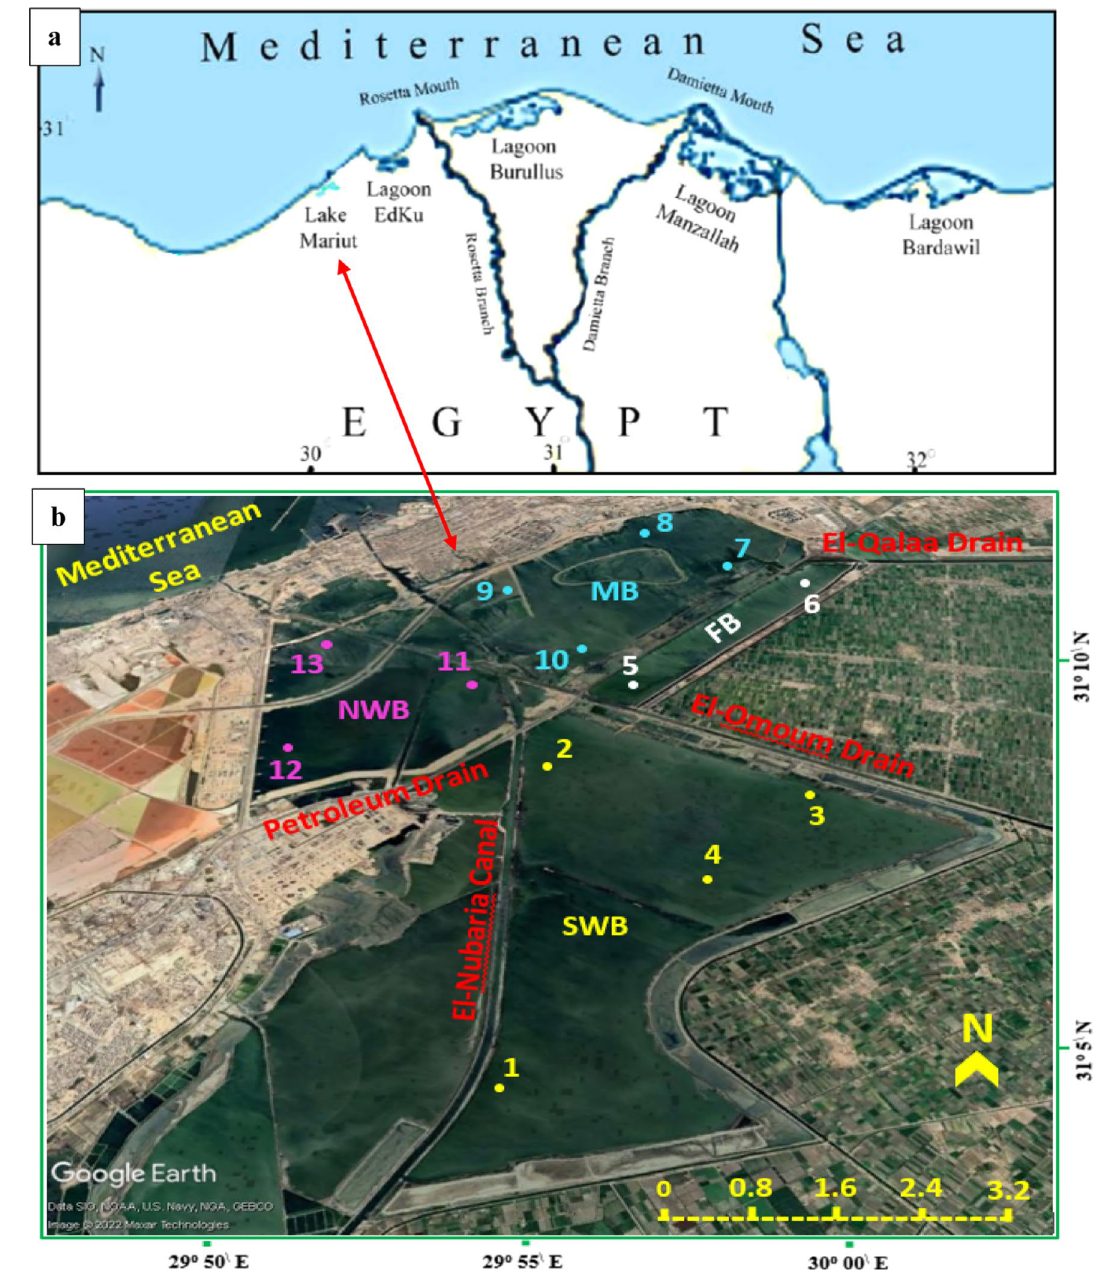
Fig. 1 A map a showing the five Northern Delta Lakes in Egypt, and b illustrating the sampling locations in Mariout